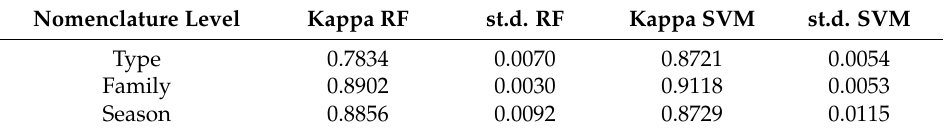
Table 5. Maximum Kappa coefficient values for all nomenclature levels; values are averaged over 20 classification iterations, with the standard deviation of the mean accuracy values (st.d.) also listed.